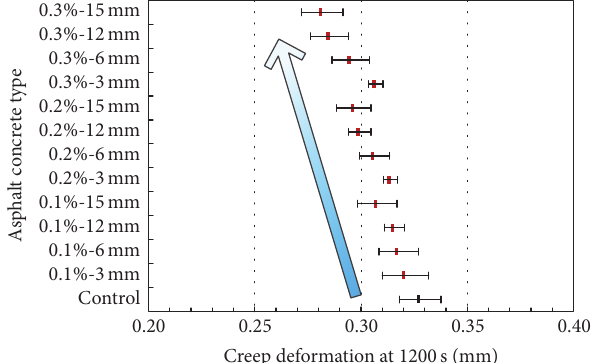
Figure 12: Creep deformations of different asphalt